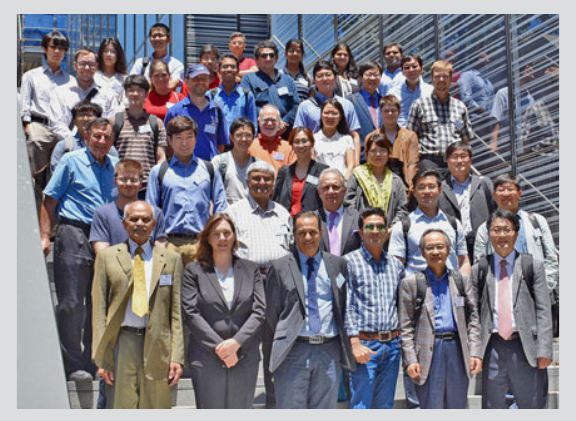
Figure 1: AKRC 2017 group photo. Figure 2: Raja Huilgol with his wife Dimitra Beroukas and daugh- ter Kalyani Huilgol after presentation of the ASR medallion.